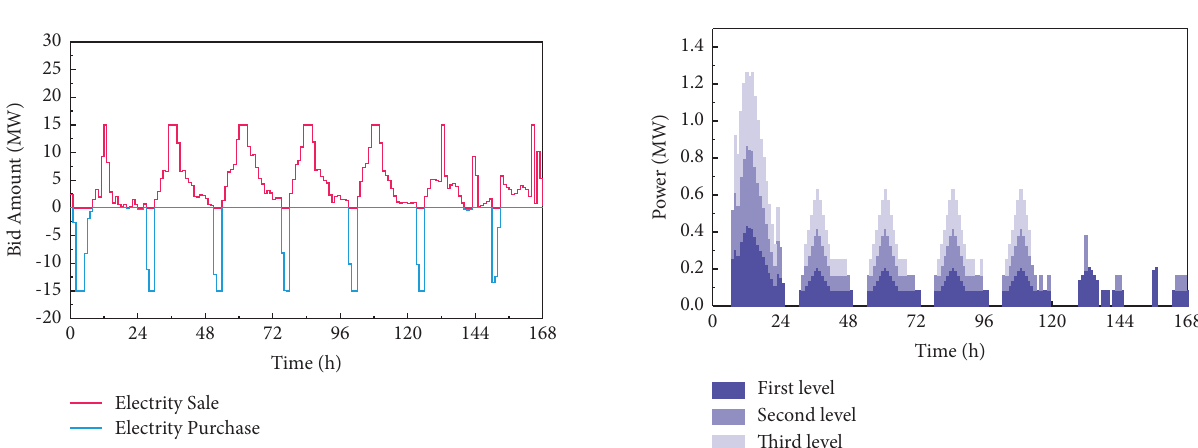
Figure 9: Operation condition of the carbon capture gas turbine when λ C � 120 E . (a) Carbon capture and CO emissions of the gas turbine.